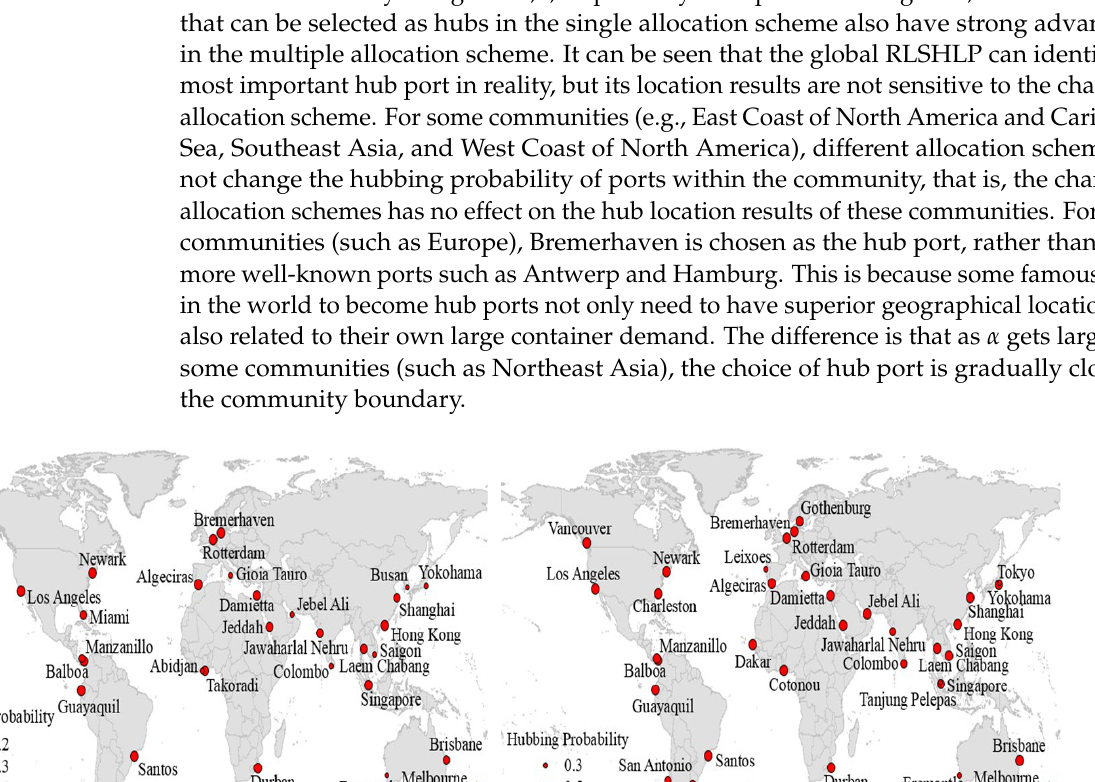
( b ) Figure 6. Hub location and feeder allocation under single allocation scheme. ( a ) CHLP, ( b ) RLSHLP. Table 2. Failure probability of each port in the RLSHLP. No.